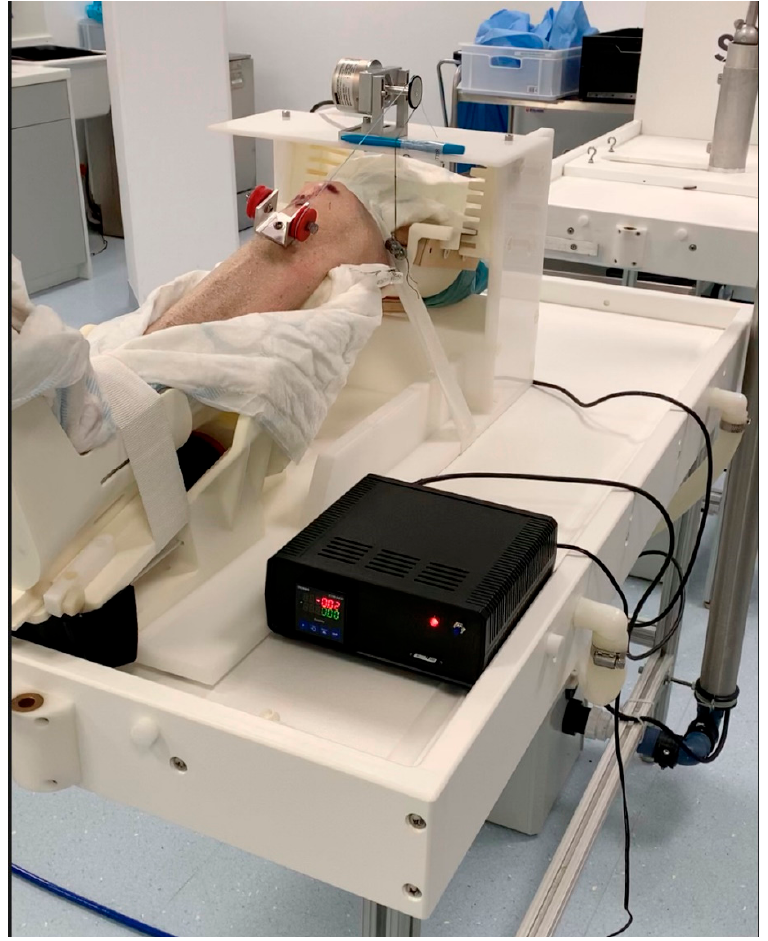
Figure 5. Measurement setup for cadaver tests.